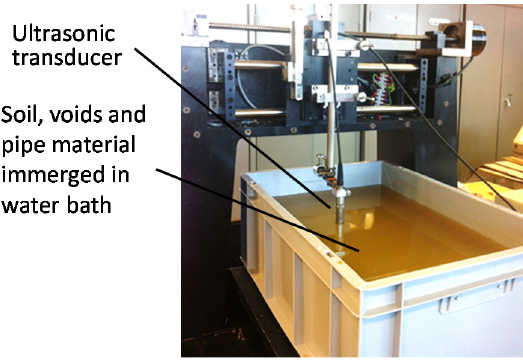
Figure 3. Photo of ultrasonic scanning tank with transducer immersed in water above the soil